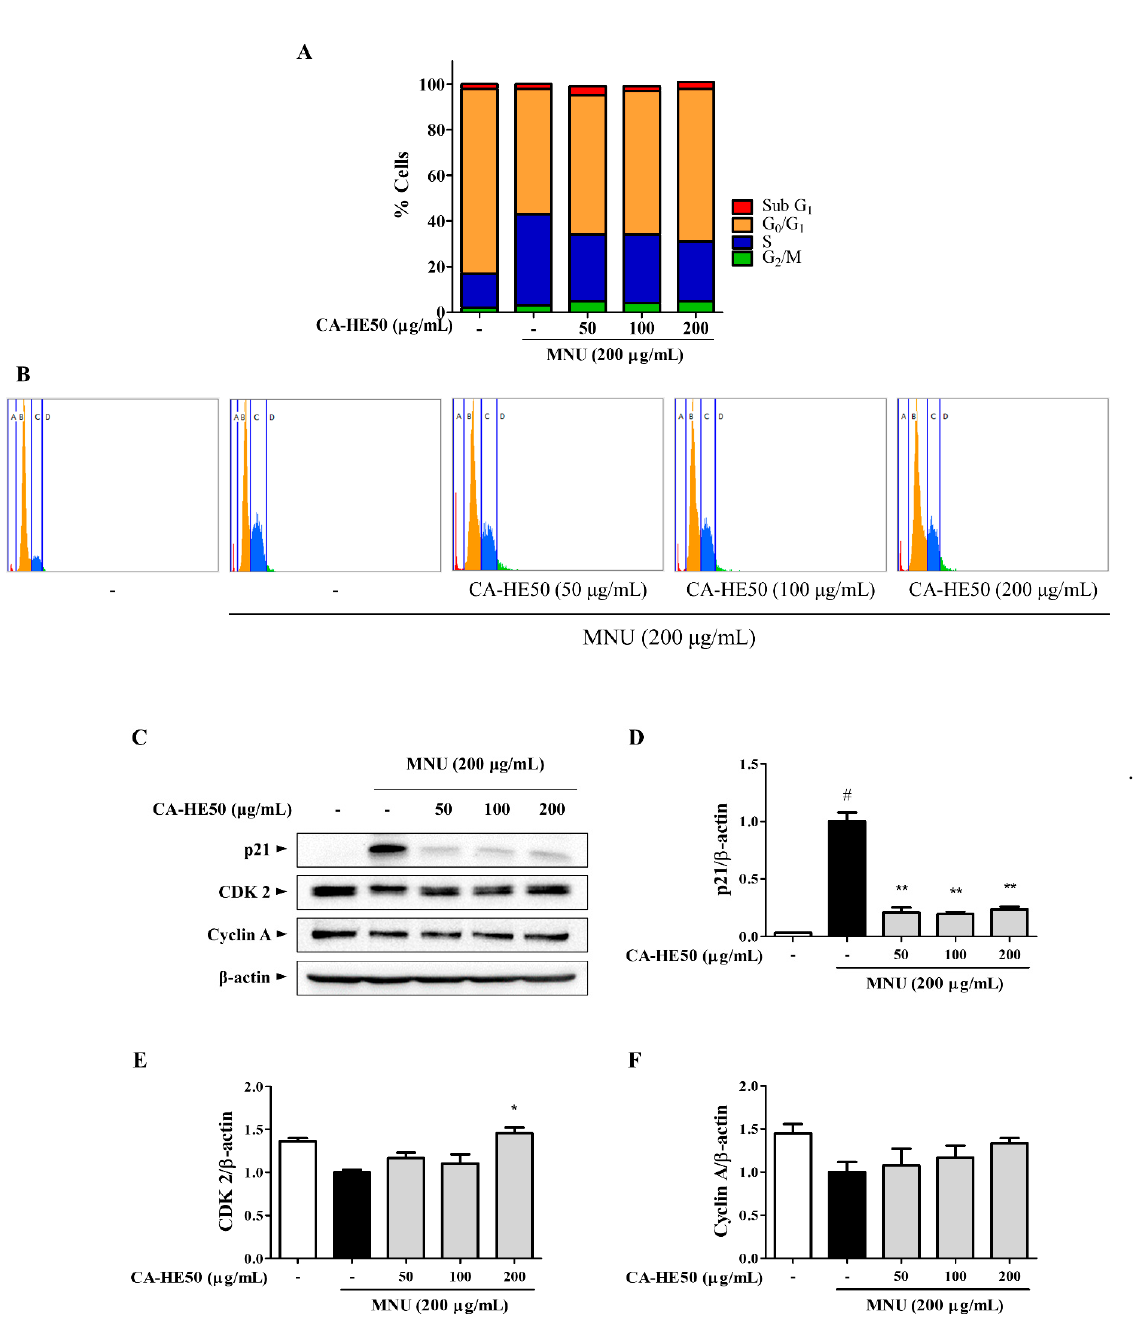
Figure 4. CA-HE50 suppressed MNU-induced S phase arrest of cells by inhibiting p21 expression. ( A , B ) Effect of MNU and CA-HE50 on cell cycle distribution. ( C ) effect of CA-HE50 on cell cycle–related protein expressions. CA-HE50 efficacy results on: ( D ) p21 protein expression; ( E ) CDK2 protein expression; and ( F ) cyclin A protein expression. # p < 0.05 vs. normal control group. * p < 0.05 and ** p < 0.01 vs. MNU-treated group. Abbreviations: MNU, N -methyl- N -nitrosourea; CDK2, cyclin-dependent kinase